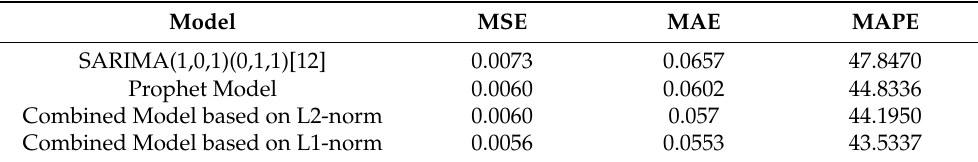
Table 3. Effect evaluation of